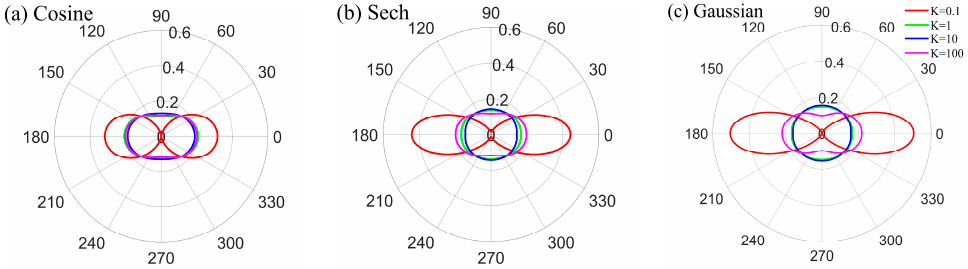
Figure 2. The ( a ) Cosine, ( b ) Sech, and ( c ) Gaussian spreading functions at 10 m/s wind speed for wave numbers of 0.1, 1, 10, and 100 rad/m.